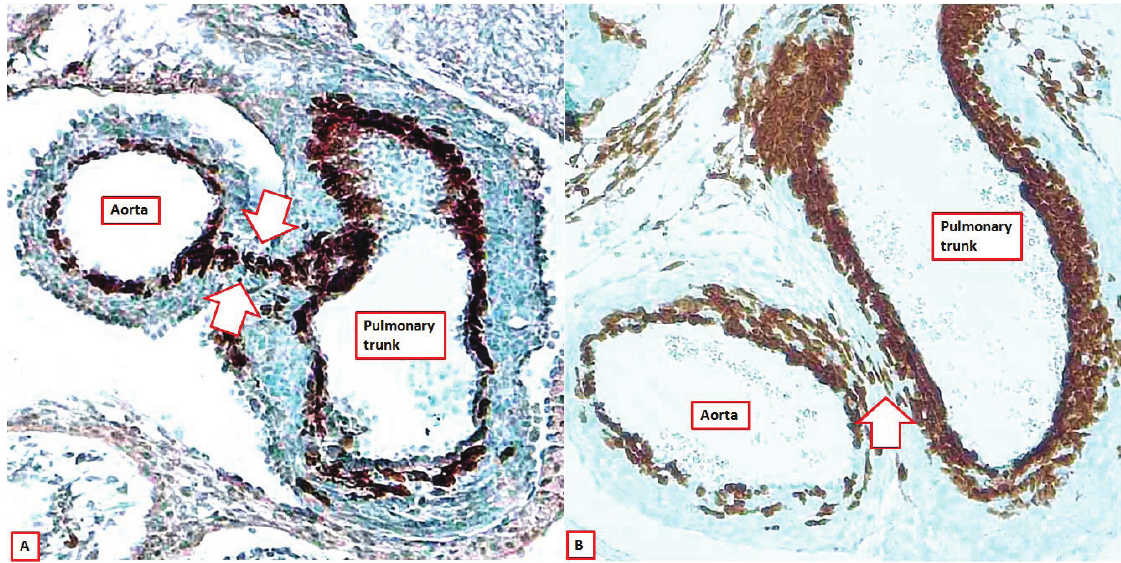
Figure 9. The images show sections across the intrapericardial arterial trunks from two Wnt1-cre mice, with the brown colouring showing the location of the cells derived from the neural crest. As can be seen, at E12.5 (panel ( A )), the neural crest cells form the sub-endothelial regions of both arterial trunks, but also show the line of fusion between the distal parts of the outflow cushions and the protrusion from the dorsal wall of the aortic sac (seam between white arrows). By E15.5 (panel ( B )), this seam is no more than an oblique strand in the extracardiac connective tissue that separates the walls of the intrapericardial arterial trunks (white